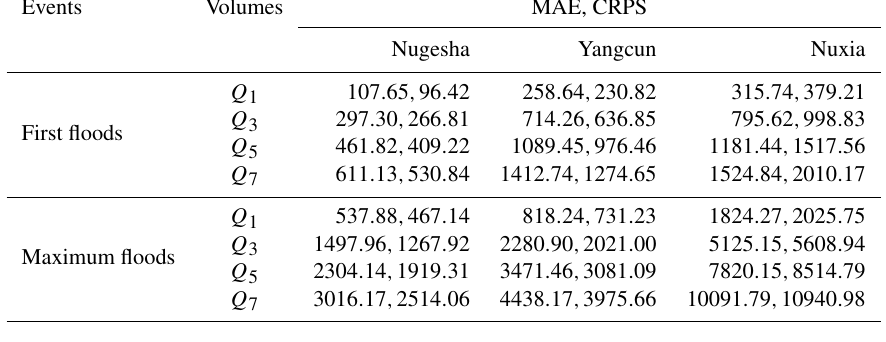
Table 2. CRPS and MAE for N simulations and S simulation on four typical flood volumes during the whole period. The results are displayed as MAE and CRPS. CRPS is the indicator used for N simulations. MAE is used for S simulation.